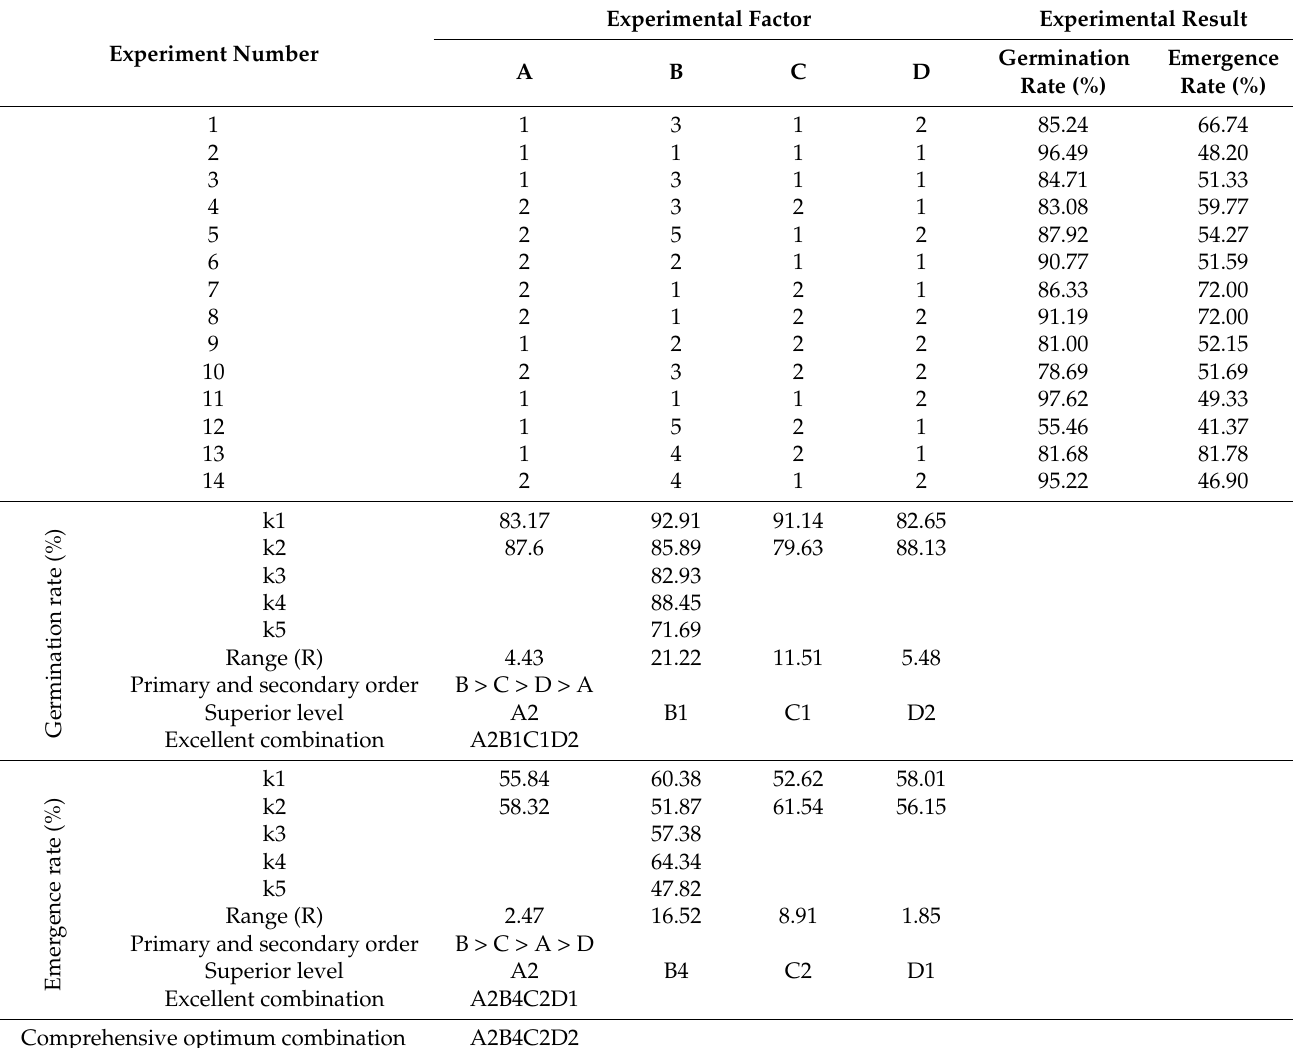
Table 3. Orthogonal experimental design and optimum results of Garanior grape seeds.